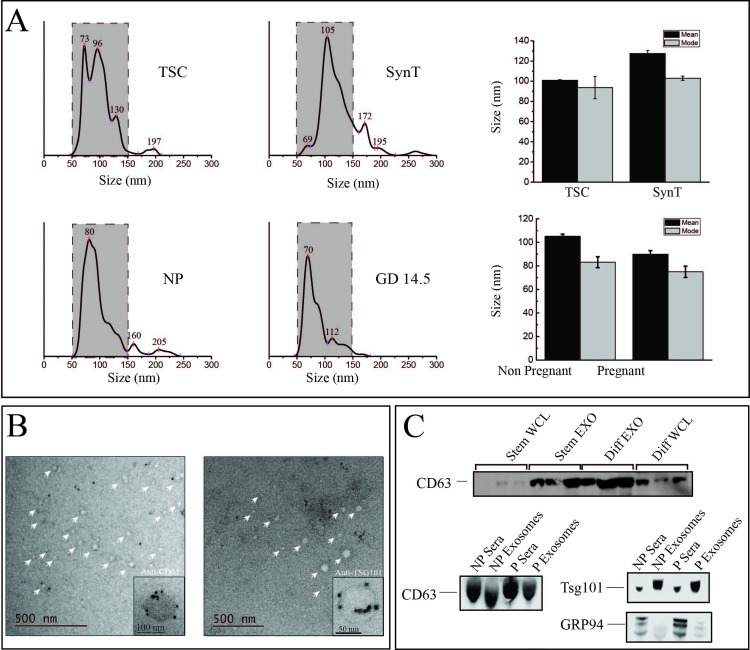
Characterization of ExoE-EVs.(A) NTA analysis of ExoQuick isolated exosome enriched extracellular vesicles (ExoE-EVs) from conditioned media of trophoblast stem cells (TSC) and syncytial cells (SynT) and murine sera of non-pregnant (NP) and pregnant mice at gestational day 14.5 (GD 14.5). Dashed gray boxes represent enrichment of exosomes in the 50-150nm range; TSC (94.9%), SynT (80.5%), NP (92.8%) and GD 14.5 (81.3%). The mean and mode of each population is also provided. (B) Representative immunoelectron micrographs of serum ExoE-EV for the exosome markers CD63 and TSG101. (C) Representative immunoblot of whole cell (WCL), exosomal (ExoE-EV) protein lysates from TSC and SynT in vitro cultures (n = 3, group) and from NP and P (GD14.5) sera and ExoE-EV.